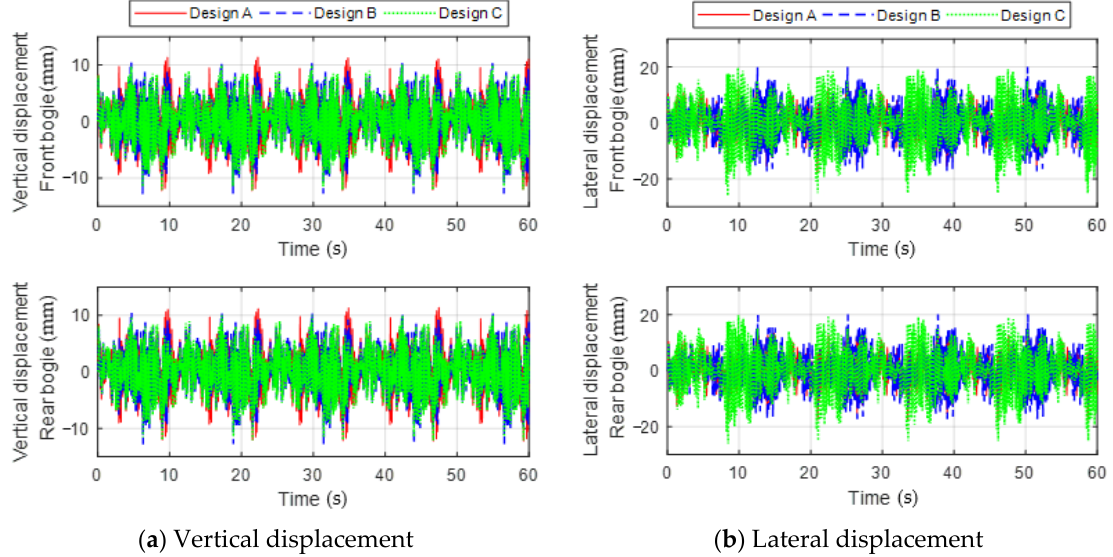
Figure 20. Vertical and lateral displacements of the front and rear bogies at a speed of 900 km/h.